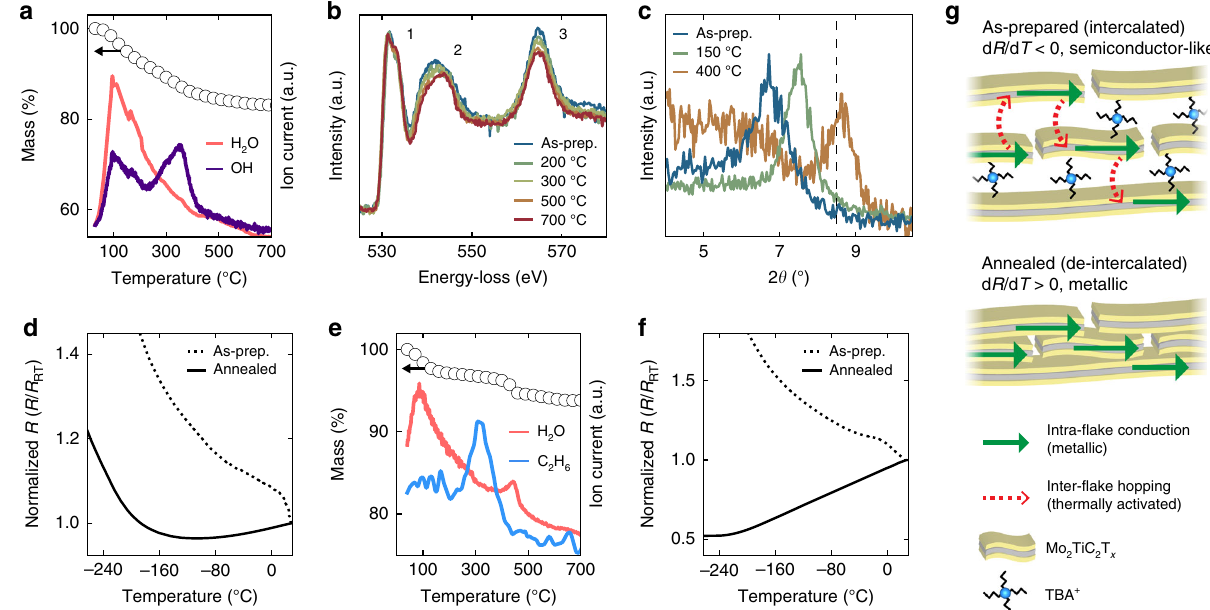
Fig. 2 In fl uence of intercalated species on the MXene resistance and d R /d T . a TGA-MS of Ti 3 CNT x showing the loss of H 2 O intercalants and – OH termination species. b In situ EELS of the normalized O K -edge of Ti 3 CNT x indicating the loss of H 2 O intercalants with annealing. c Ex situ XRD of the Ti 3 CNT x (002) peak for an as-prepared thick sample, i.e., vacuum fi ltered and free-standing, as well as thick samples annealed at 150 °C (in vacuum) and 400 °C (in Ar). The peak shift to higher 2 θ values represents a decrease in the inter-layer spacing. The dashed vertical line represents the approximate position of the Ti 3 C 2 T x (002) peak after annealing at 150 °C, taken from ref. 6 . d Temperature-dependent PPMS resistance measurements of a thick as- prepared (intercalated) Ti 3 CNT x sample and the de-intercalated sample annealed to 700 °C within the TEM. R RT is the room temperature resistance. e TGA-MS of Mo 2 TiC 2 T x showing the loss of H 2 O intercalants and the decomposition of TBA + intercalants. f Temperature-dependent PPMS resistance measurements of a thick as-prepared (intercalated) Mo 2 TiC 2 T x sample and the de-intercalated sample annealed to 775 °C within the TEM. The